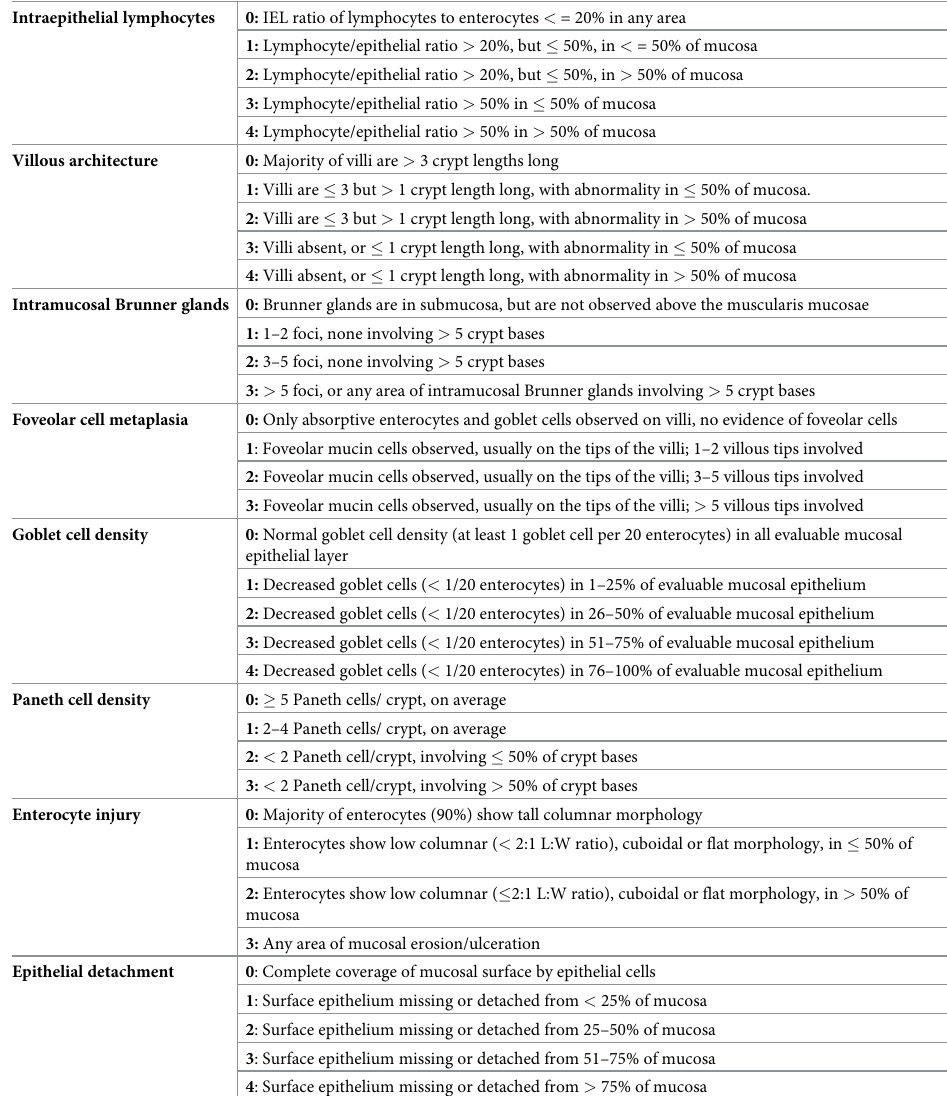
infiltration, intramucosal Brunner glands, foveolar cell (gastric mucin cell) metaplasia,